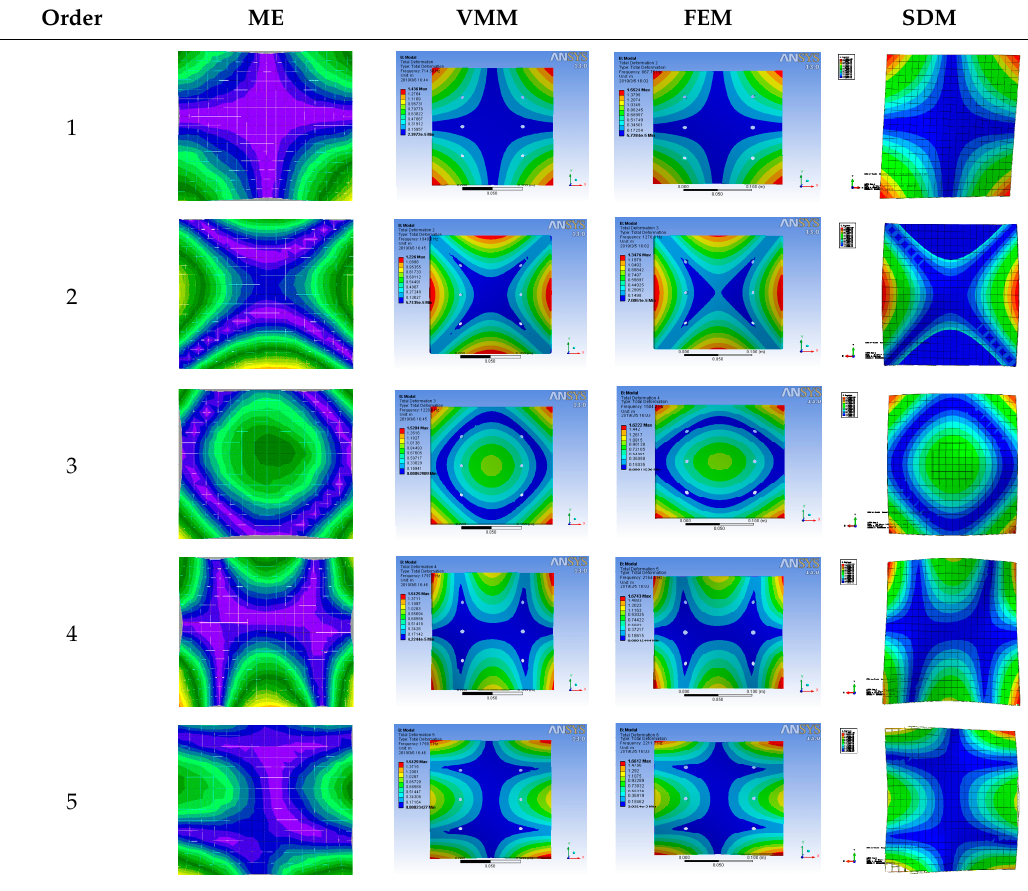
Figure 6. Curve of frequency response of specimen by experiment. Table 2. Comparison of the first five mode shapes obtained by the simulation and modal